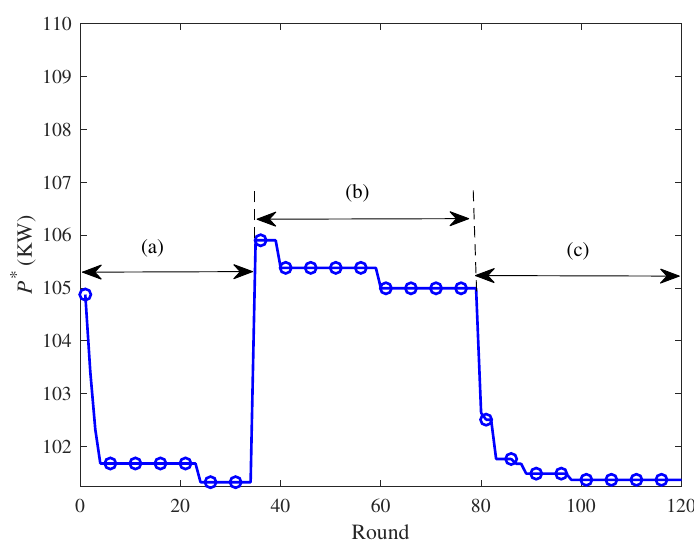
Figure 7. The iteration of BRS under different number of nodes.